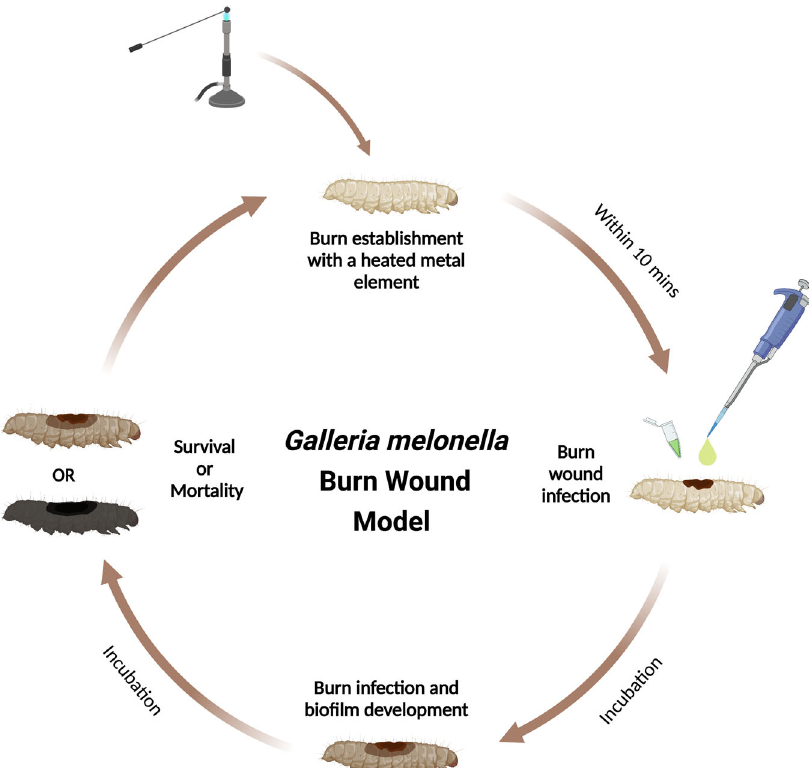
Fig. 2 The G. mellonella burn wound and infection model. The burn is established on the back of the larvae with a heated metal element, closely followed by inoculation of the wound with pathogens. The infection is then allowed to establish and the bio fi lm to develop during the incubation process. The survival and mortality rates can be easily recorded throughout the incubation steps due to the melanisation of the larvae which is proportional to the severity of their condition. Additional wounds can be established by repeating the procedure as described. Created with